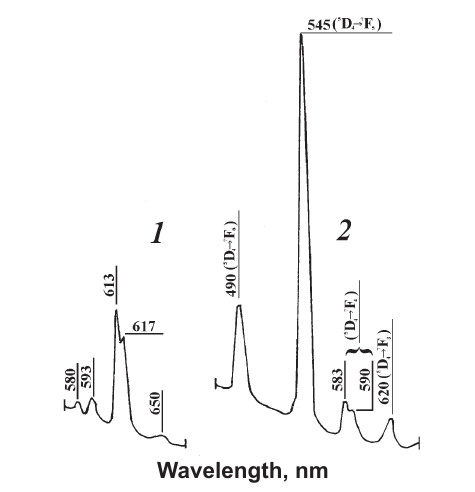
Figure 10. Luminescence spectra of Eu(III) ( 1 ) and Tb(III) ( 2 ) complexes with tripodal ligand 1 in acetonitrile solution ( С =5×10 -5 М , С =5×10 -4 М ). Eu, Tb Lig